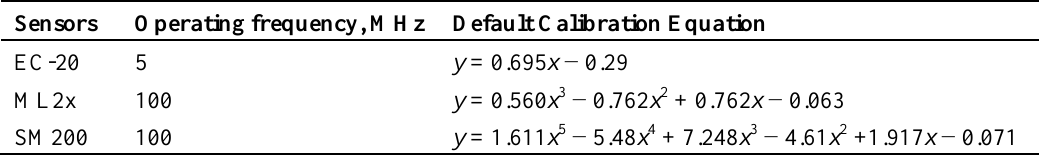
Table 1. Sensors used in this study, their operating frequency, and default calibration equations.